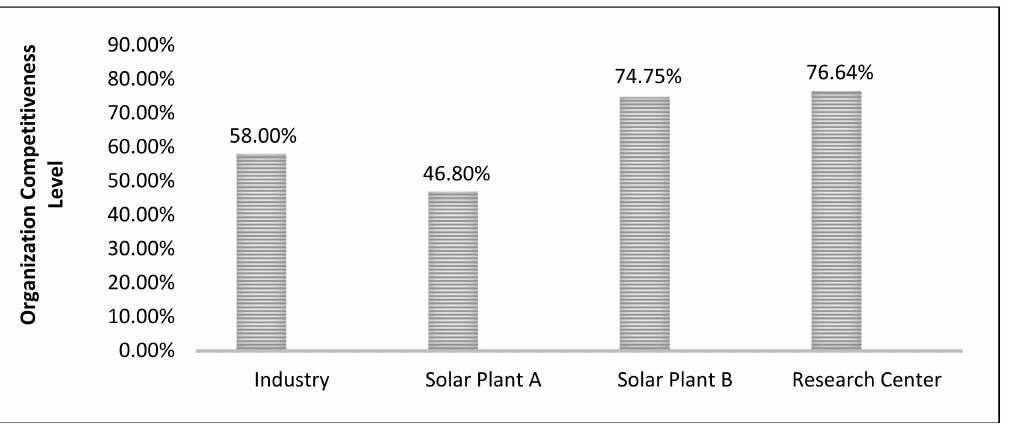
Figure 7. Organization Competitiveness